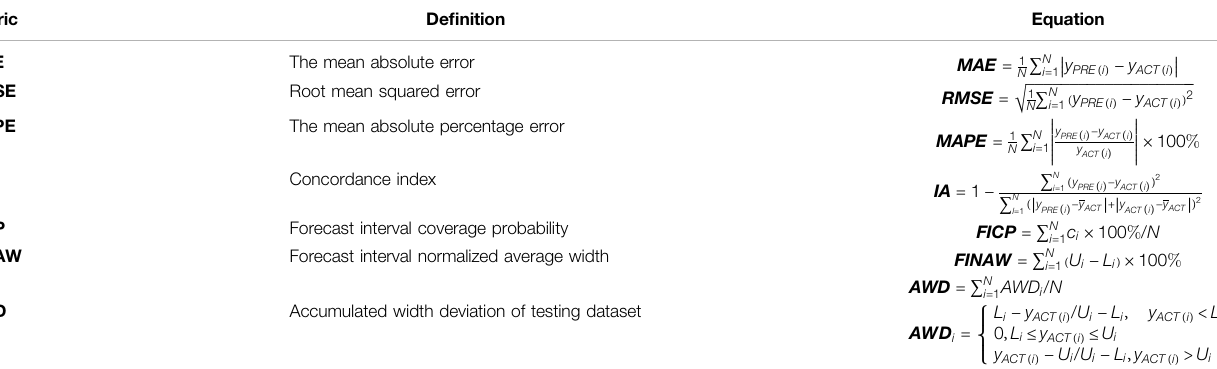
TABLE 4 | Basic evaluation metrics.